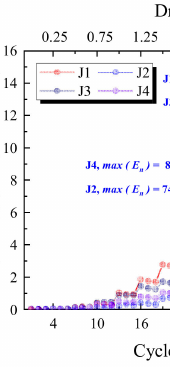
Figure 16. Loop energy per cycle.